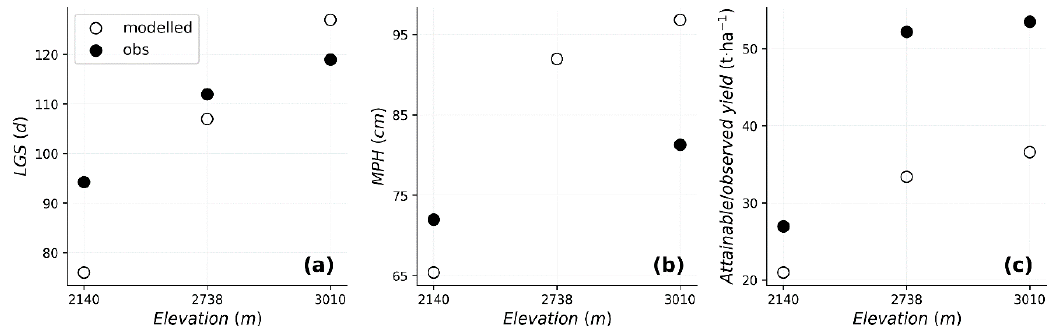
Figure 9. GECROS-modeled (open dots) and observed (closed dots) values for crop growth variables and yield for Tegecha (2140 m), Chencha (2738 m), and Gircha (3010 m) stations in the Gamo Highlands: ( a ) LGS (d), ( b ) MPH (cm), and ( c ) observed (attainable) crop yield (t ∙ ha − 1 ). Note that MPH data for Chencha are missing.